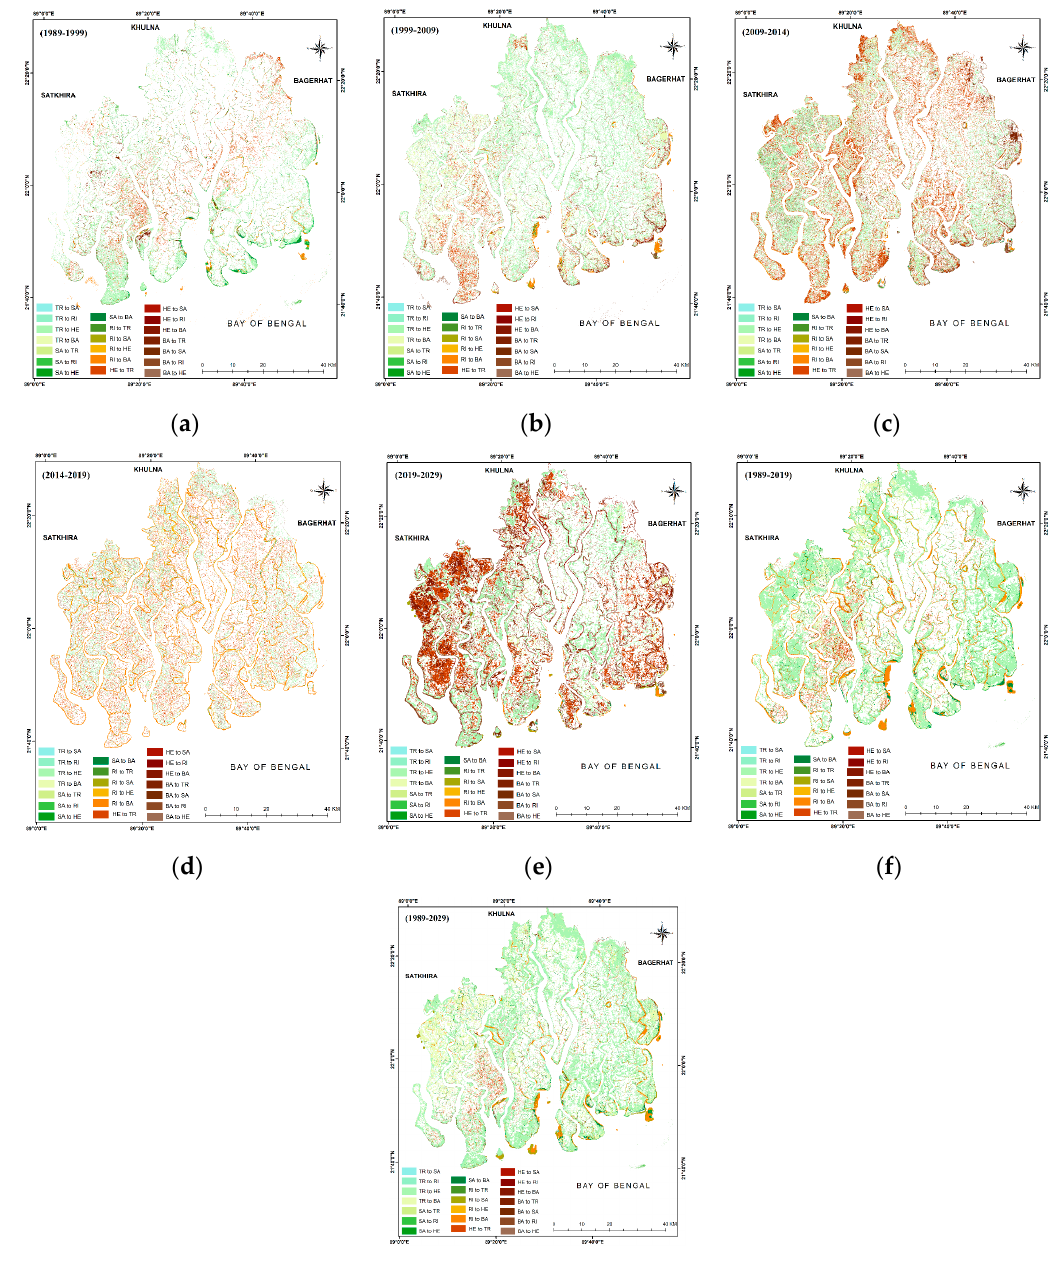
Figure 7. SRF transition maps in different time periods in 1989–2029. ( a ) Transition map 1989–1999; ( b ) transition map 1999–2009; ( c ) transition map 2009–2014; ( d ) transition map 2014–2019; ( e ) future transition map 2019–2029; ( f ) overall transition map (1989–2019); and ( g ) overall transition map